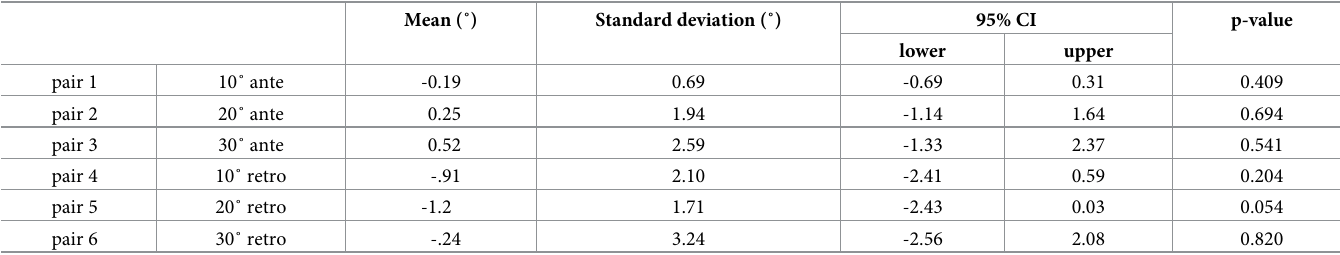
Table 3. Overview of paired Student’s t-test for each step of